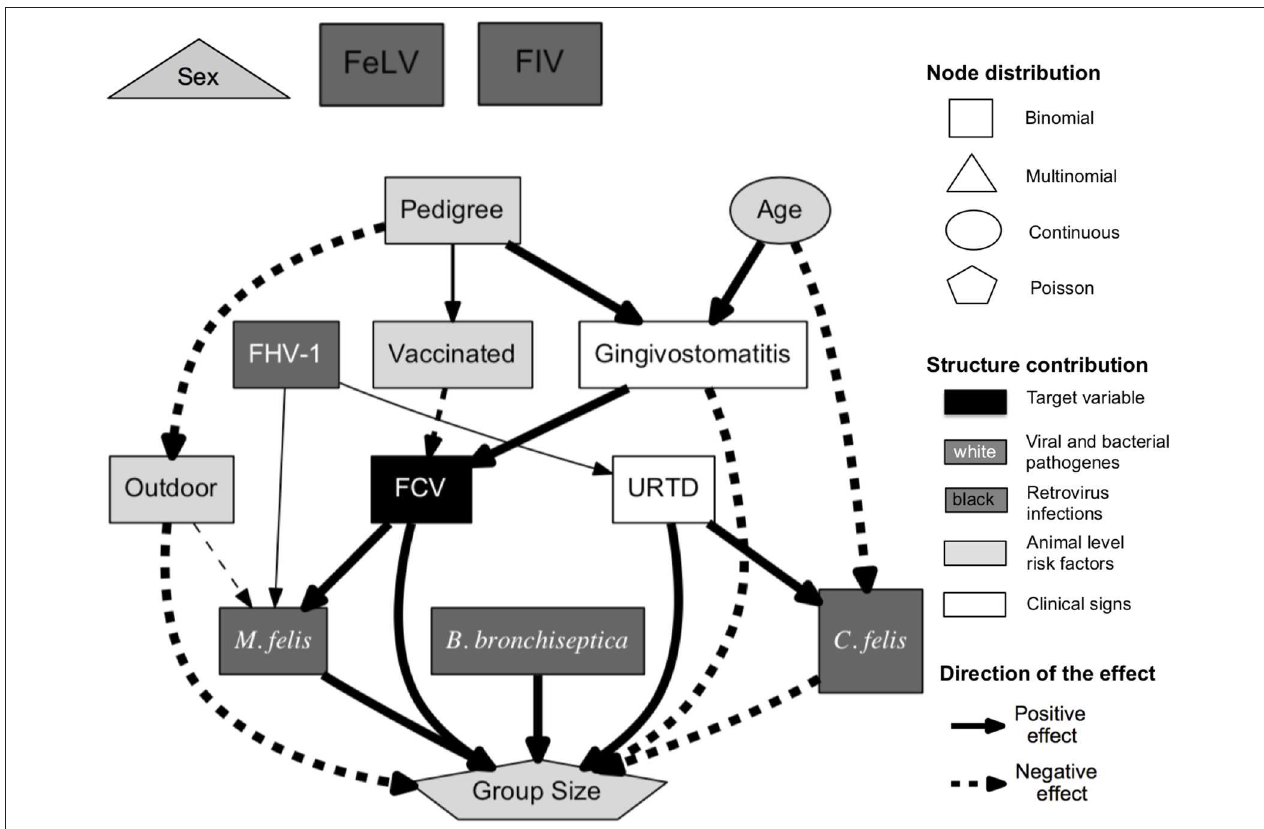
FIGURE 7 | Pruned additive Bayesian network model selected using BIC score, with a maximal parent limit of seven, constructed by pooling results across 100,000 MCMC moves [thinning factor of 100, burn-in phase of 17 % of the total number of steps, and non-informative global network prior (except the already mentioned network restriction)]. The squares are binomial, the pentagon is Poisson, ovals are Gaussian, and the triangle is based on multinomial distributed variables. The FCV node is directly associated with the factors vaccination status, gingivostomatitis, M. felis , and group size. The solid arrows represent positive effects and the dashed arrows, negative effects. The thickness of the arrow is proportional to the support probability. The gray scale values of the nodes encode their level of contribution (target variable, viral and bacterial pathogens, retrovirus infections, clinical signs, and animal level risk